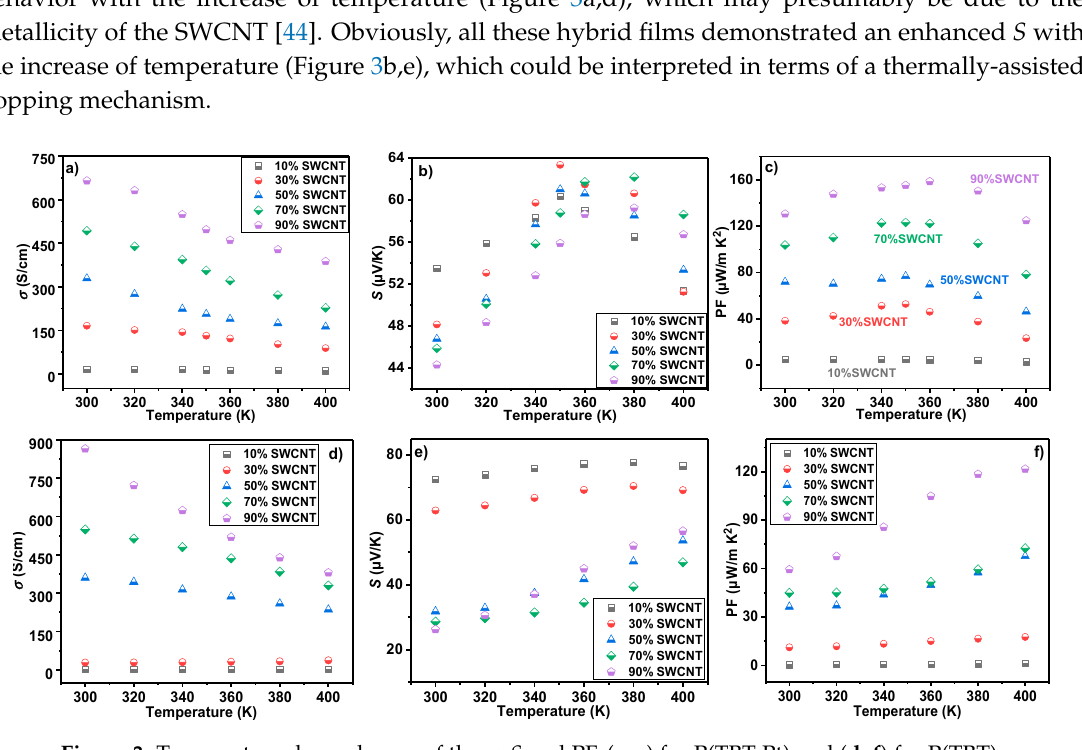
Figure 3. Temperature dependences of the σ , S and PF, ( a – c ) for P(TBT-Pt) and ( d – f ) for P(TBT).